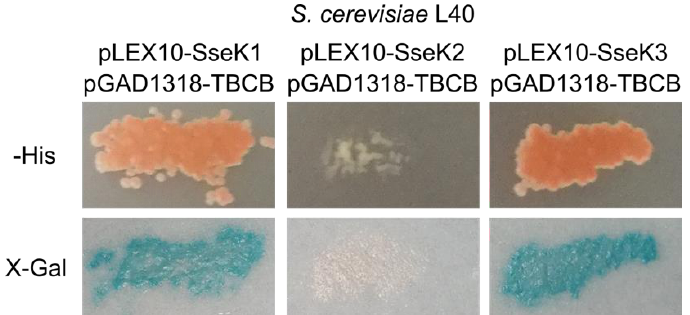
Figure 5. SseK3 interacts with TBCB in the yeast two-hybrid system. Strain L40 of S. cerevisiae was cotransformed with derivatives of plasmids pLEX10, to generate fusions of SseK1, SseK2, or SseK3 with the DNA-binding domain of LexA, and pGAD1318, to generate a fusion of TBCB with the activation domain of Gal4, as indicated. The interaction between the two hybrid proteins is shown by the growth in the absence of histidine (-His), and detection of blue color in the presence of X-Gal after a β -galactosidase filter assay.